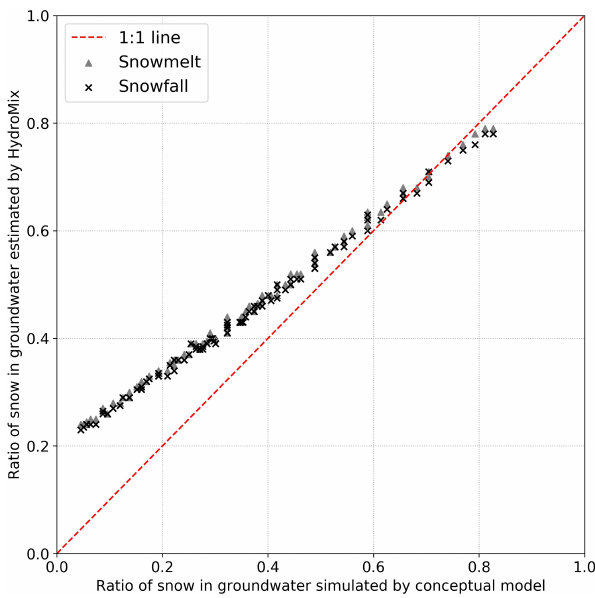
Figure 6. Ratios of snow in groundwater estimated with HydroMix plotted against ratios obtained from the hydrologic model for the last 2 years of simulation. Also shown are the separate results obtained by using samples of either snowmelt or snowfall. The full range of ratios is obtained by varying rainfall and snowmelt recharge efficiencies from 0.05 to 0.95. The numbers of rainfall, snowfall, and snowmelt days are 39, 24, and 107 in the last 2 years of simulation.